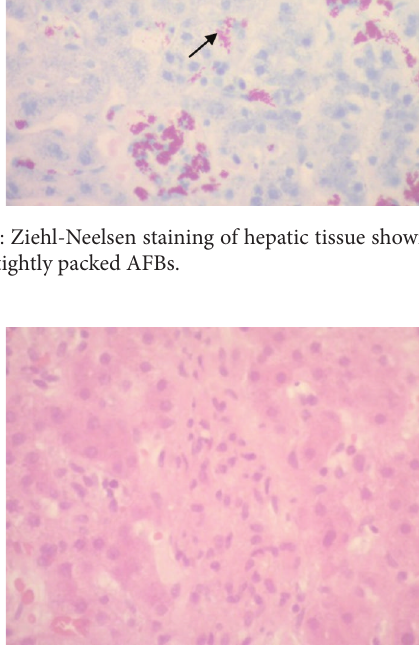
Figure 2: A poorly formed granuloma with surrounding hepatic tissue stained with H&E (Haematoxylin and